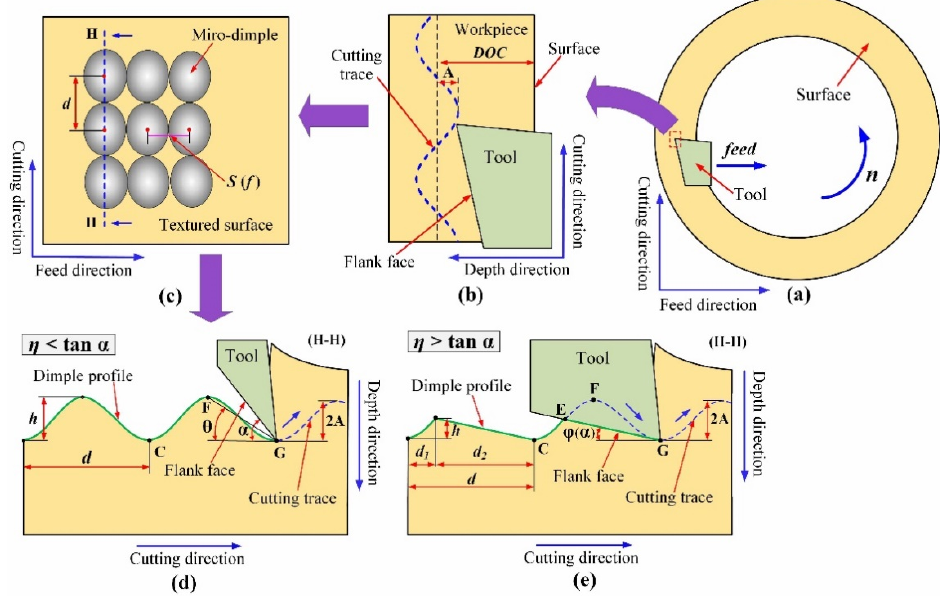
Figure 1. Illustration of the surface texturing process by 1D UVAT: ( a ) end face; ( b ) cutting process; ( c ) micro-textured surface; ( d ) dimple profile fabricated under η < tan α ; ( e ) dimple profile fabricated under η > tan α .